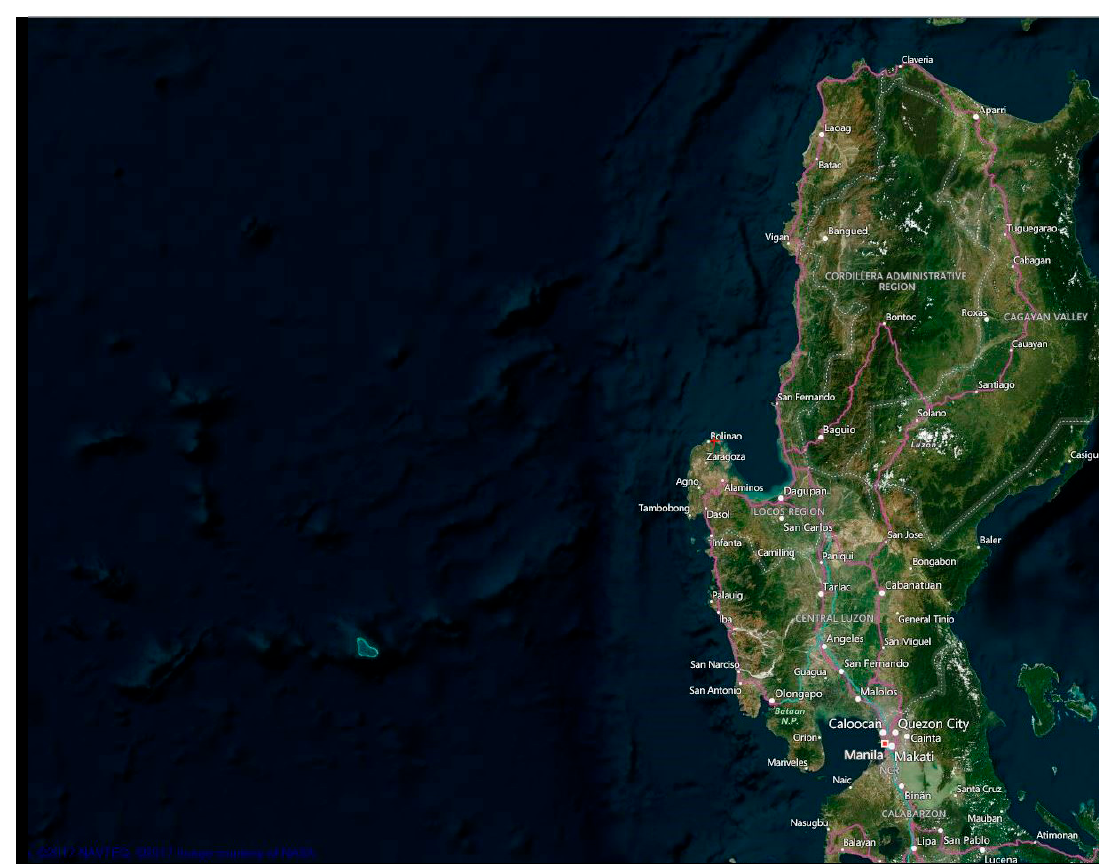
Figure 7. An overview of the experimental area. Most of the area is covered by ocean.